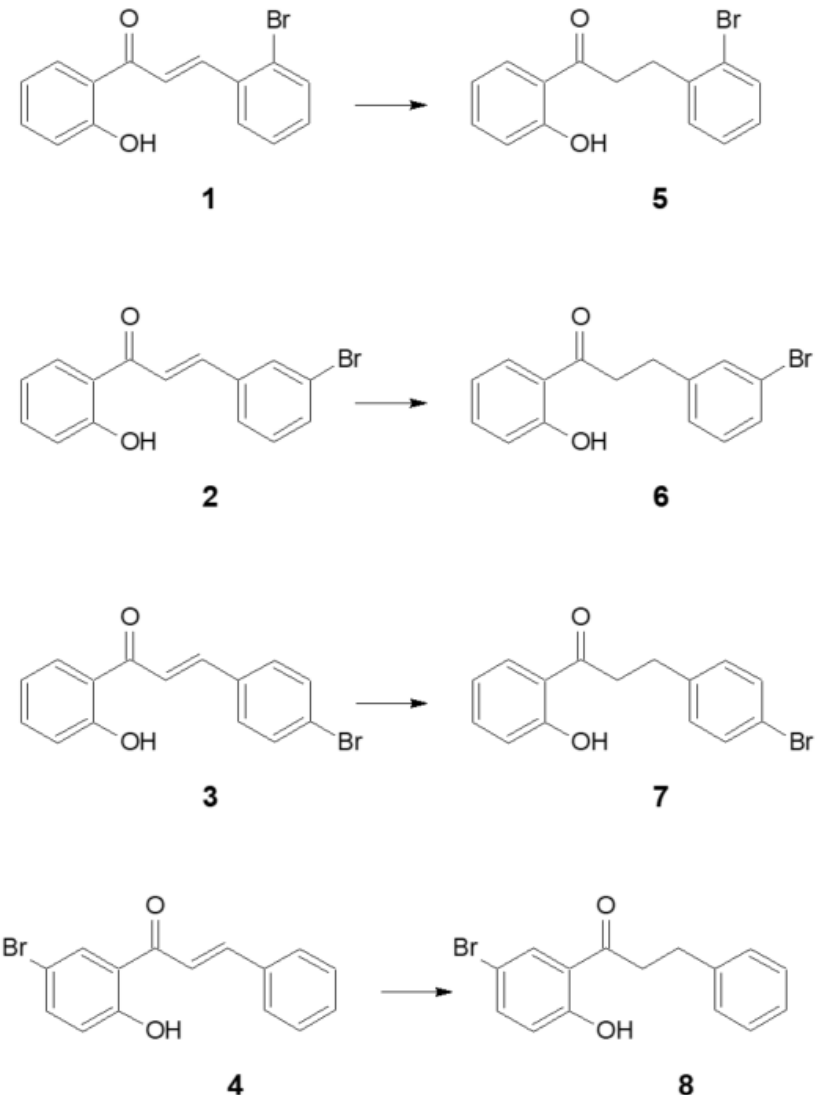
Figure 2. Biotransformation of bromochalcones ( 1 – 4 ) obtained by chemical synthesis.